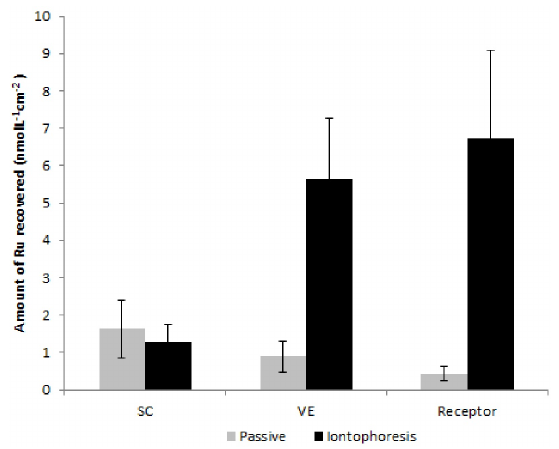
Figure 8. Amount of Ru recovered from the SC, VE, and receptor solution after 4 h of passive and iontophoretic permeation of Ru-NO dissolved in aqueous solution at pH 7.